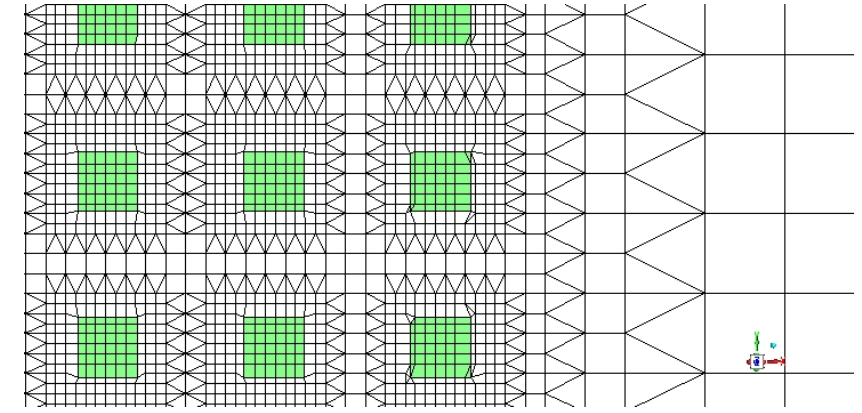
Figure 5. Particulars of the suspended ceiling mesh. In green is indicated the perforation